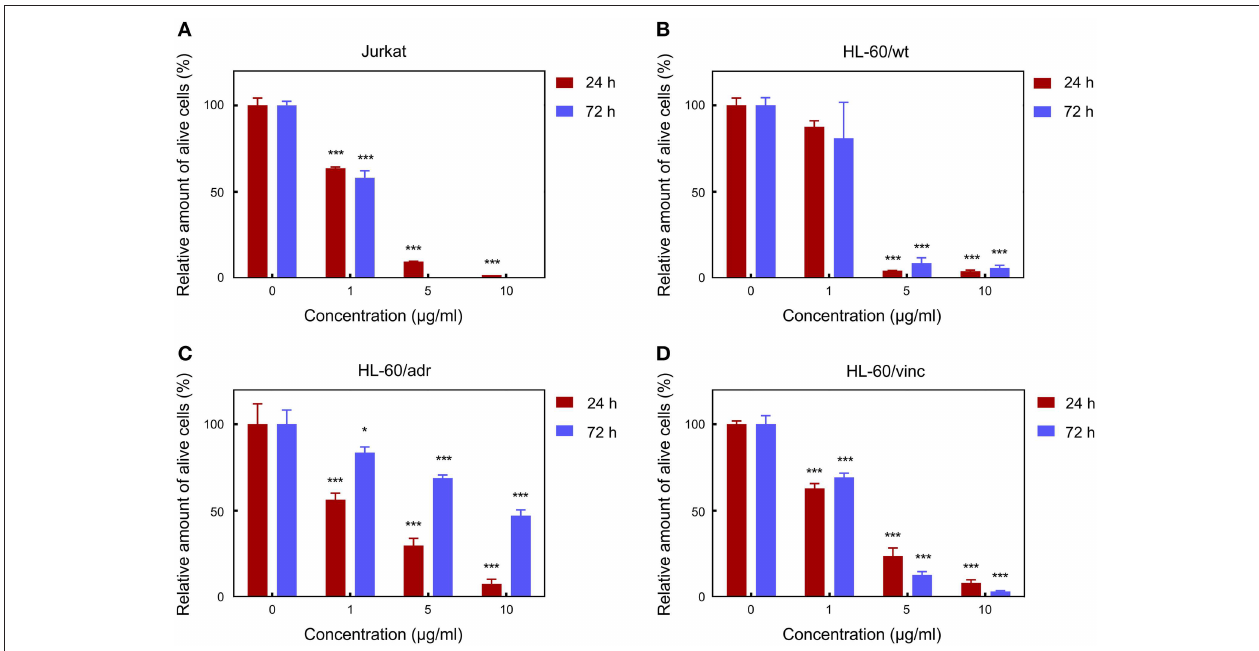
FIGURE 3 | Cytotoxicity of the mag.SLPs against (A) T leukemia Jurkat cells, (B) human myeloid leukemia HL-60/wt cells, (C) human myeloid leukemia HL-60/adr cells resistant to doxorubicin, and (D) human myeloid leukemia HL-60/vinc cells resistant to vincristine determined by trypan blue exclusion test on 24 and 72h. * p ≤ 0.05 and *** p ≤ 0.001 compared to the non-treated control